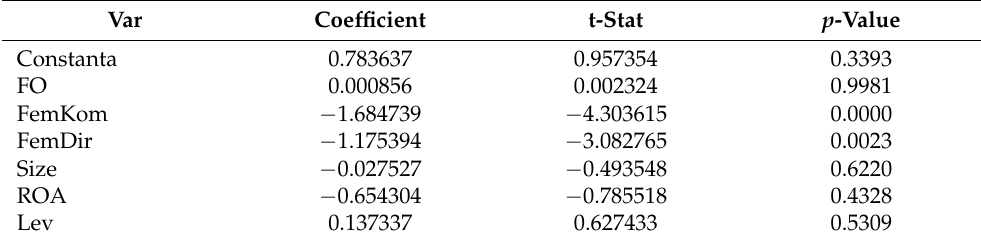
Table 5. Robustness Test Fixed Effect